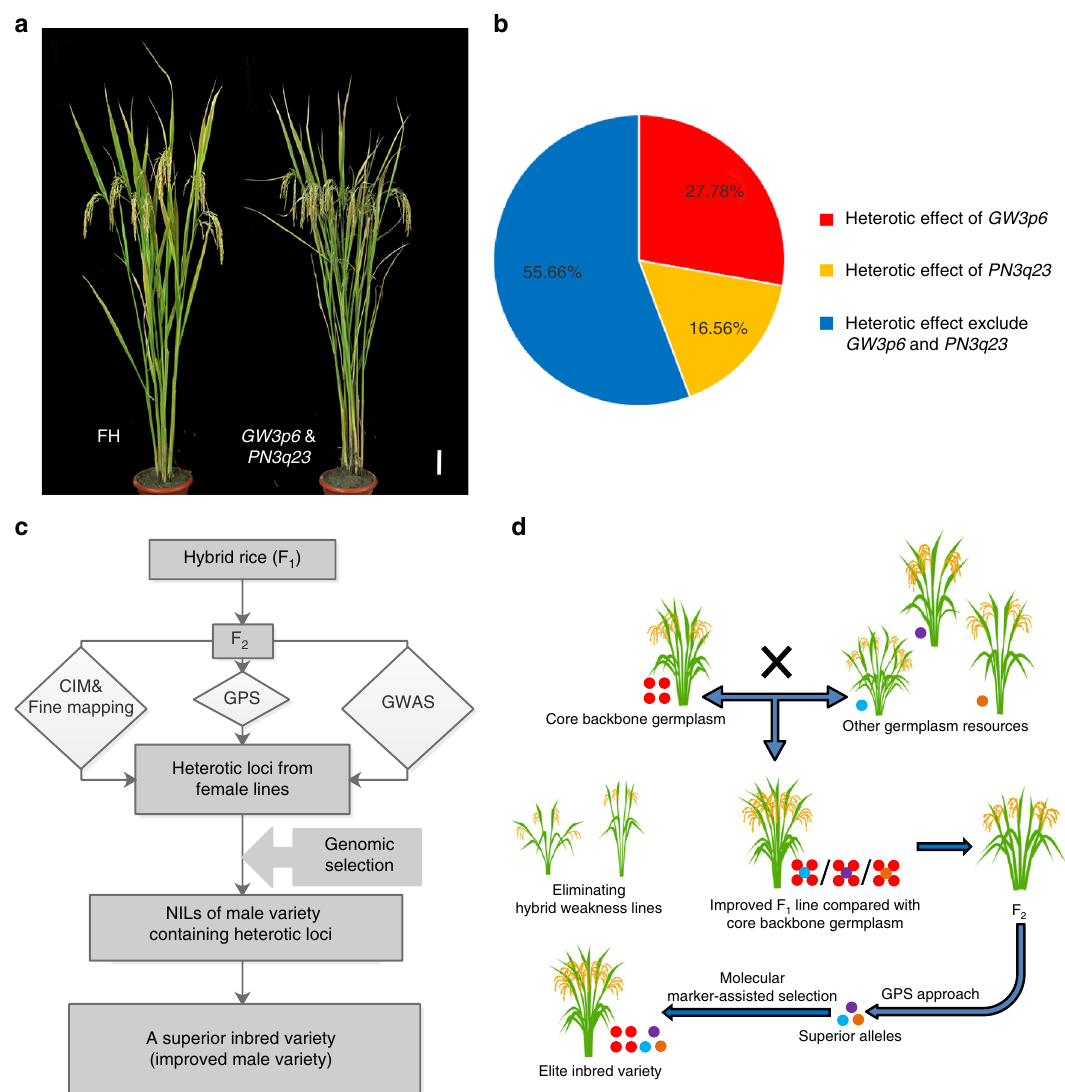
Fig. 5 The heterosis effect of OsMADS1 GW3p6 in rice breeding. a The phenotype of FH plants and plants carrying two heterotic genes GW3p6 & PN3q23 . Scale bar, 10 cm. b The yield-related contribution of GW3p6 and PN3q23 . The proportion of GW3p6 and PN3q23 in yield-related heterosis effect are indicated in the pie chart. The color red and orange represent the heterosis contribution rate of GW3p6 and PN3q23 respectively. The color blue indicates the heterosis contribution rate of heterotic genes exclude GW3p6 and PN3q23 . c The fl ow chart of improvement breeding about hybrid rice in this study. d The strategy of rice-improvement breeding in conventional rice and hybrid rice. Colored circles represent superior alleles, for example, the blue, purple and brown circles denote superior alleles associated with tiller number, panicle type and plant architecture. Souce data of Fig. 5b are provided as a